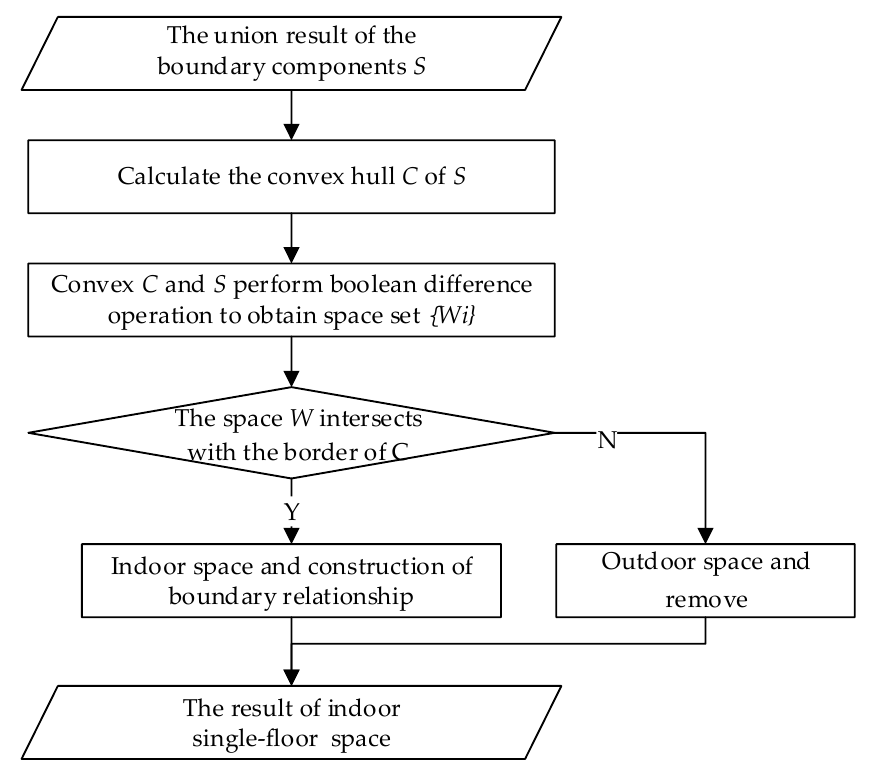
Figure 5. Flowchart for extracting a single-floor space.